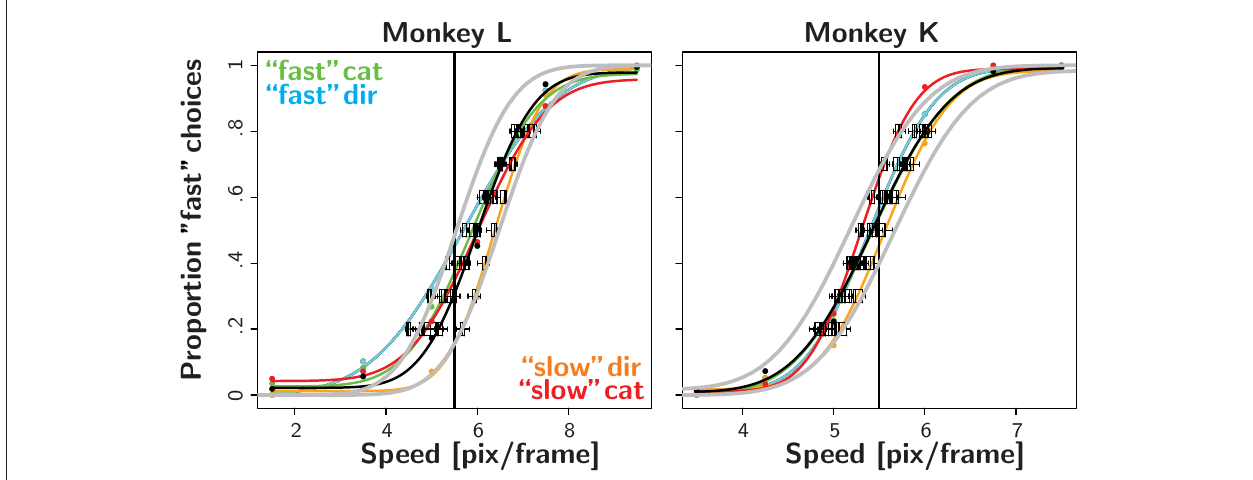
Figure 3 | reward likelihood bias. Psychometric functions for the first four recording session in the reward likelihood condition. Conventions as in Figure 2 . In contrast to the reward magnitude condition, monkeys did not shift their PSE in the biased conditions.